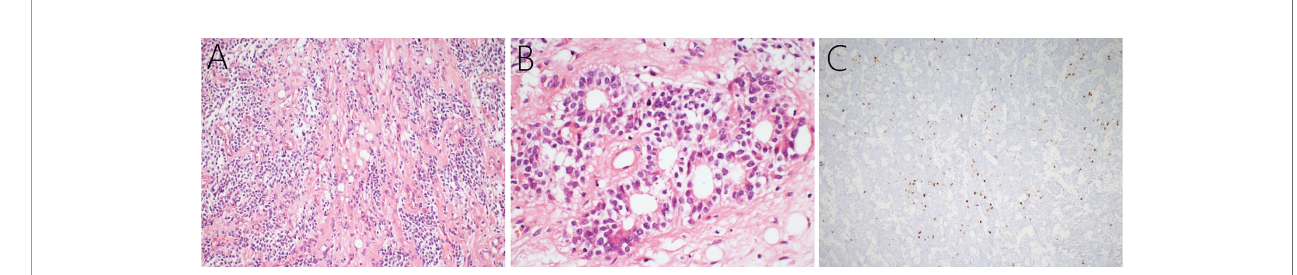
FIGURE 2 | Histopathology of the cerebellar liponeurocytoma. Hematoxylin and eosin-staining showing that a large number of small round tumor cells with low mitotic activity grow in sheets, and clusters of fat cells (A) and that chrysanthemum clusters (B) are seen among the cells. Immunohistochemical examination presented a Ki-67 index of 5% grossly, and 10-20% focally